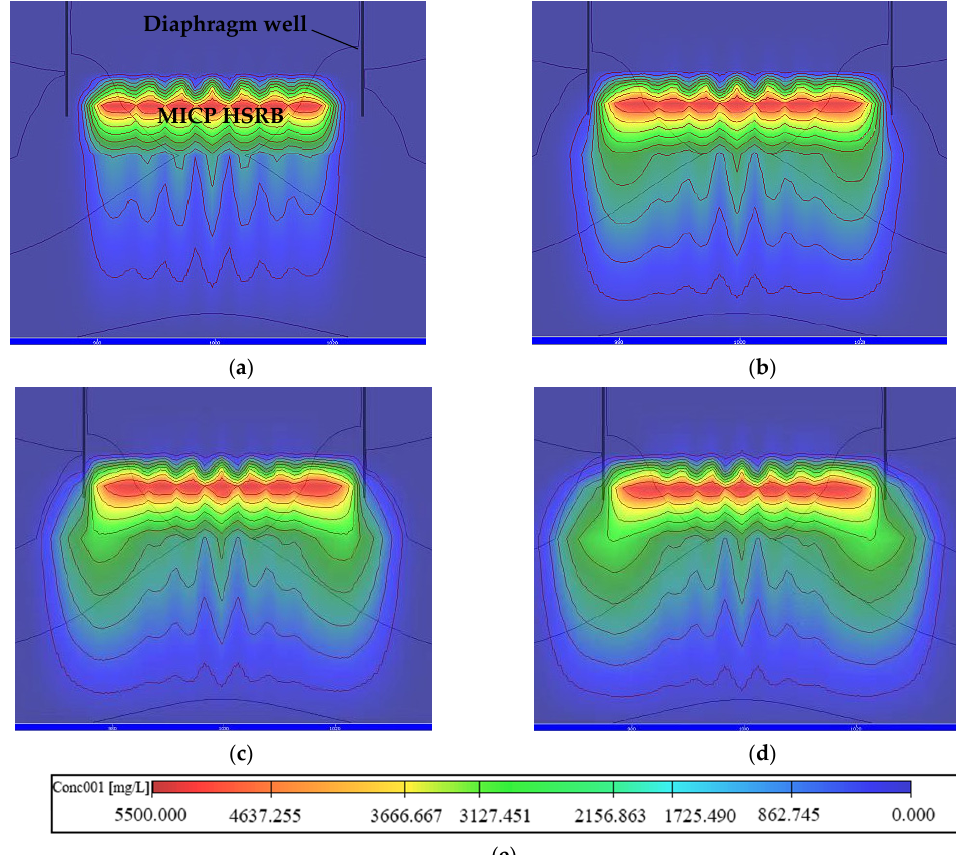
Figure 18. Horizontal migration of S. pasteurii in different time periods: ( a ) 1d; ( b ) 2d; ( c ) 3d; ( d ) 4d; ( e ) Legend.